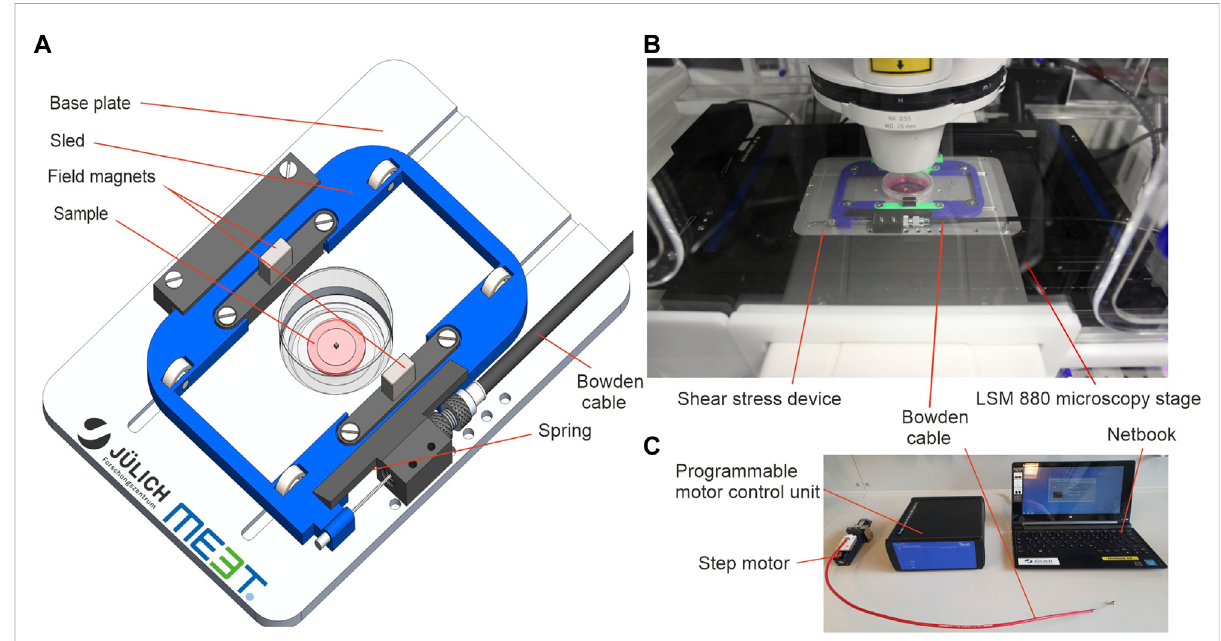
FIGURE 1 Amagneticdevicetoapplysolidshearstressonultrasofthydrogels. (A) Engineeringschematicofthemagneticshearstressdevice. (B) Imageof the device mounted onto the table of an inverse confocal microscope with LCI incubation unit. The step motor and the control unit are located outside the incubator. (C) Image of the accessory tools used to operate the device. Custom software on a standard netbook is used to program a motor control unit with a drive protocol with de fi ned speed, amplitude, dwell time and number of repetitions. The motor control unit drives a high-precision step motor connected to the device via a Bowden